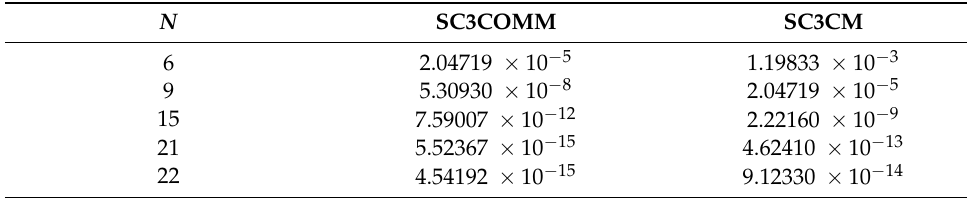
Table 1. Maximum absolute error of Example 1.